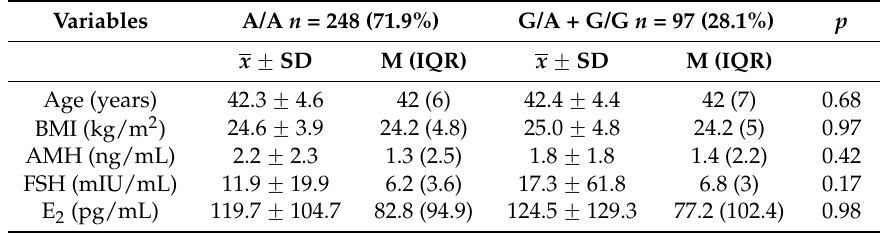
Table 4. The genotypes of the AMHR2 2482 A > G polymorphism (rs2002555) vs. age, BMI, hormone levels and ovarian parameters in the follicular phase in healthy late reproductive stage women ( n = 345). Variables A/A n = 248 (71.9%) G/A + G/G n = 97 (28.1%)